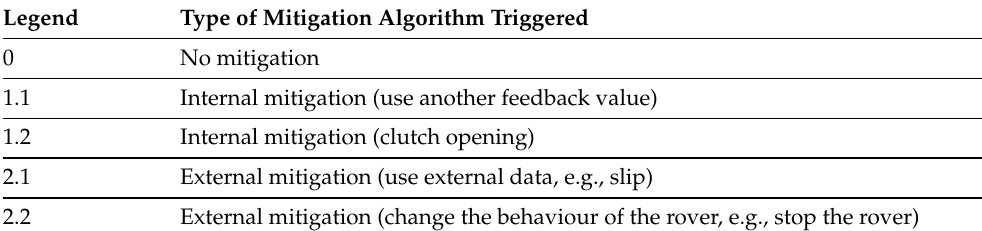
Table 4. Traction subsystem mitigation levels.